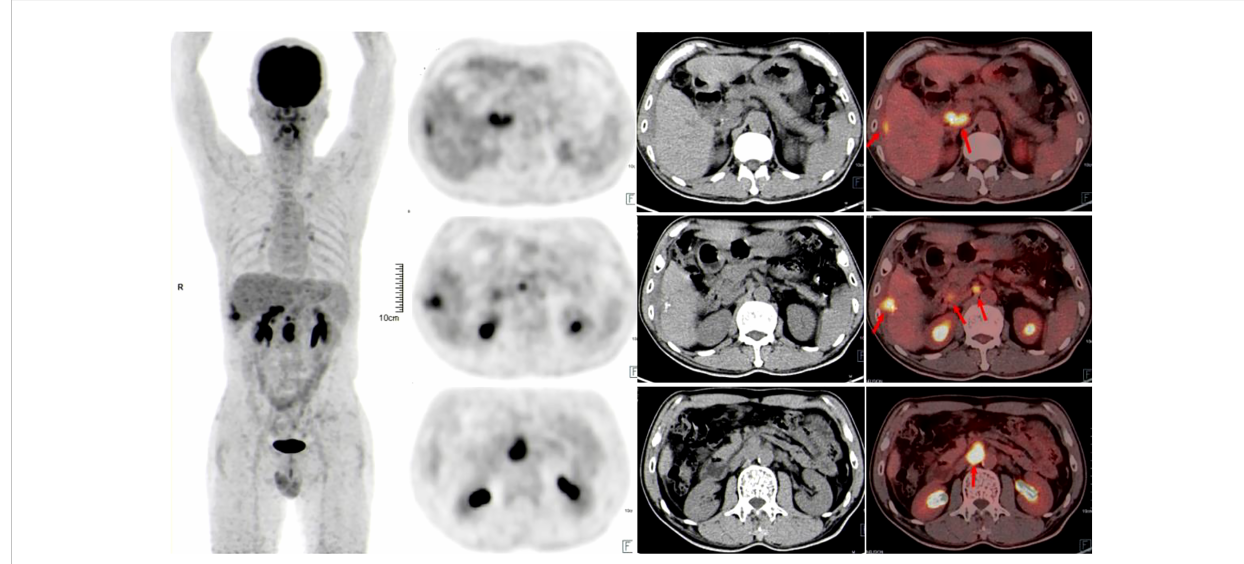
(Figure 4). TACE was unavailable because of no obvious tumor staining during angiography. Hence, RFA of the lesions in the S5/S6 of the liver was performed owing to the results of the PET-CT. After the surgery, the patient was started on immunotherapy with tislelizumab (200 mg every 3 weeks). After four treatment cycles, contrast-enhanced MRI showed a complete response with no increase in local tumor size (in the arterial phase) or new lesion and a signi fi cant reduction in the size of the ALNs ( ≤ 10 mm) (Figures 1E, 2C) assessed by RECIST 1.1. Although the patient experienced fatigue and developed skin rashes with pruritus over